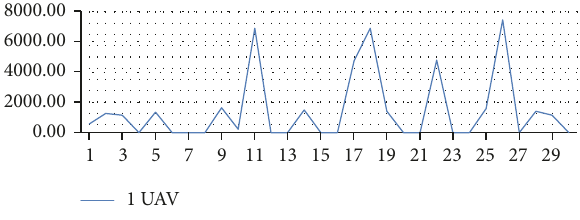
Figure 18: La Palma PSO path planning results.